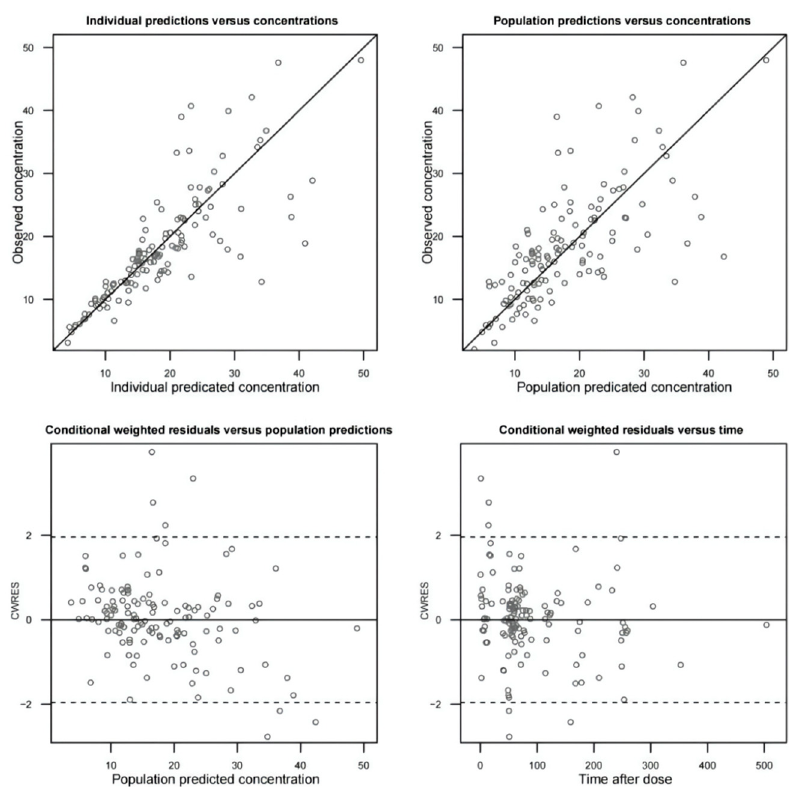
Figure 2. The typical goodness-of-fit diagnostic plots of the final model were as follows: individual prediction concentrations (IPRED) versus observed vancomycin plasma concentrations (DV) ( top left ), population prediction concentrations (PRED) versus observed vancomycin plasma concen- trations ( top right ), conditional weighted residuals (CWRES) versus population prediction (PRED) concentrations ( bottom left ), and conditional weighted residuals versus time after dose (TIME) ( bottom right ). The diagonal lines in the upper panels represent lines of